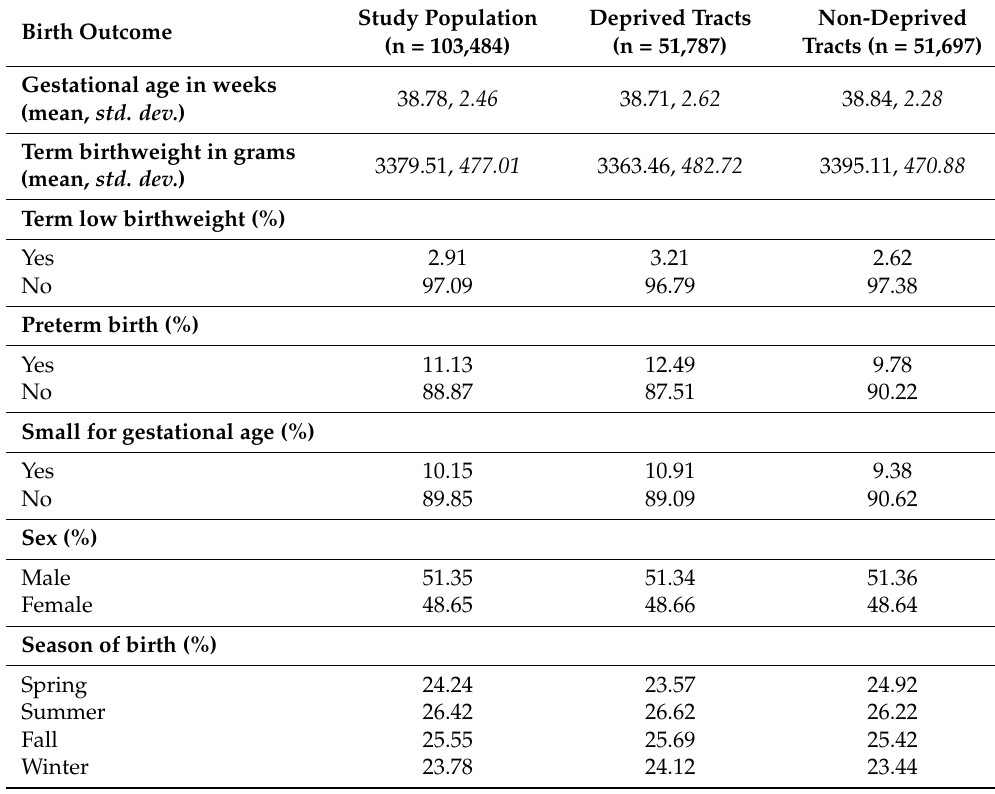
Table 1. Birth outcomes and infant covariates.